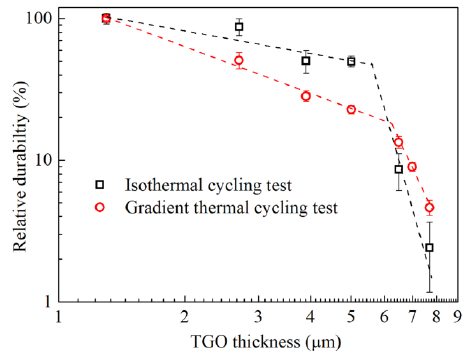
Fig. 42 Relative durabilities of APS TBCs plotted as a function of the TGO thicknesses under the burner cycling test and the furnace cycling test. Reproduced with permission from Ref. [41], © ASM International 2017; Ref. [215], © The American Ceramic Society